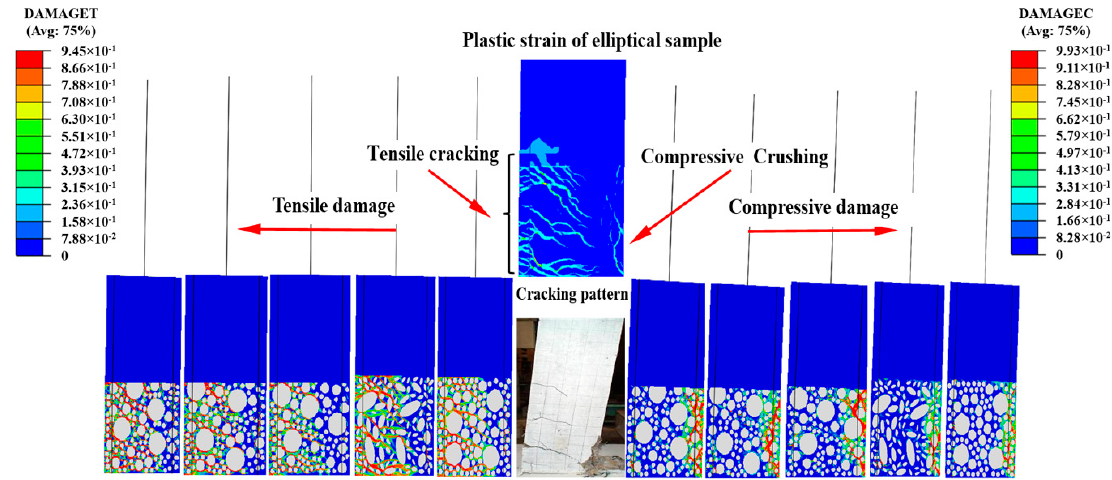
Figure 15. Damage pattern in CDP-based multiscale models.